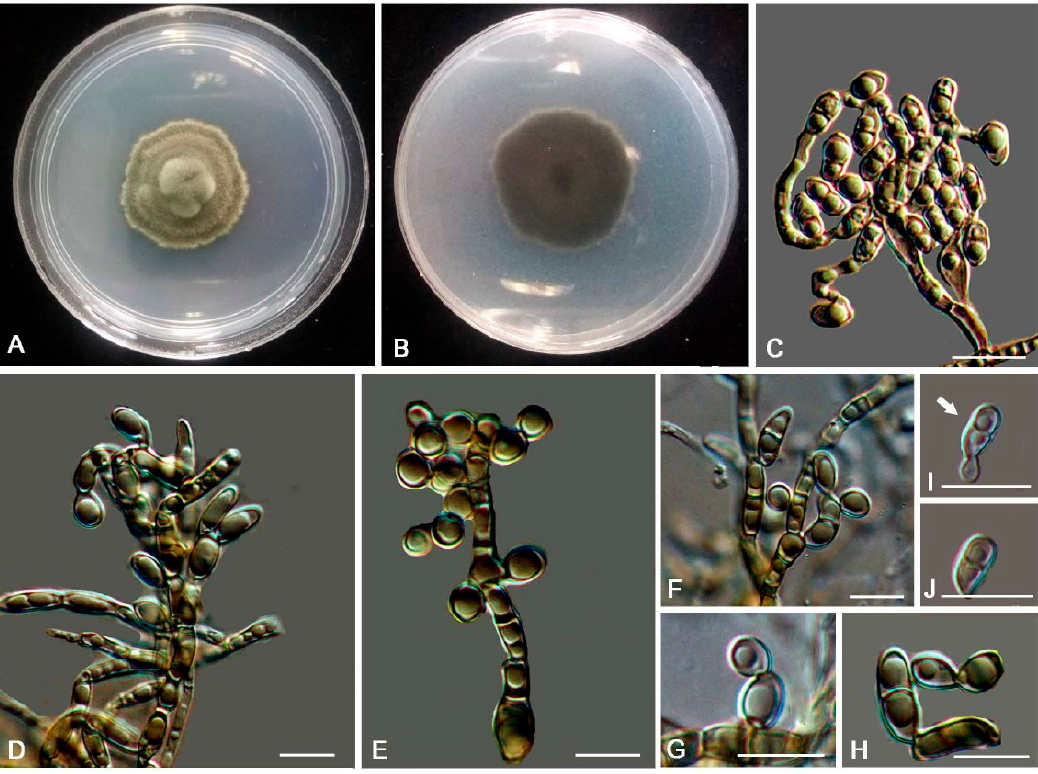
Figure 22. Exophiala nagquensis (CGMCC 3.17333). ( A , B ) Forward and reverse of colony on MEA. ( C – F ) Conidiophores with conidiogenous cells. ( G – J ) Conidia and budding cells. Scale bars: ( C – J ) = 10 μ m.